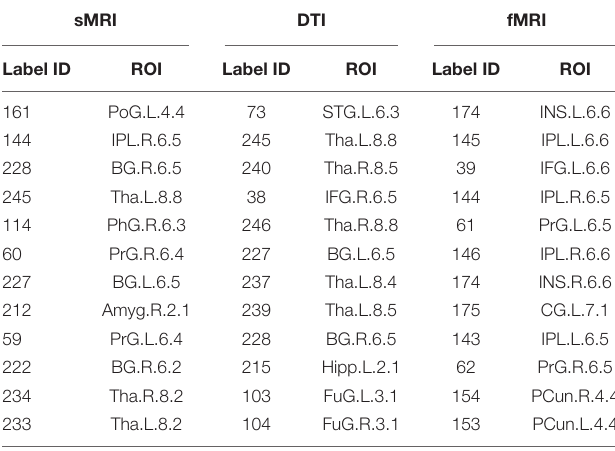
TABLE 3 | The hubs of HC based on different modal brain network. sMRI DTI fMRI